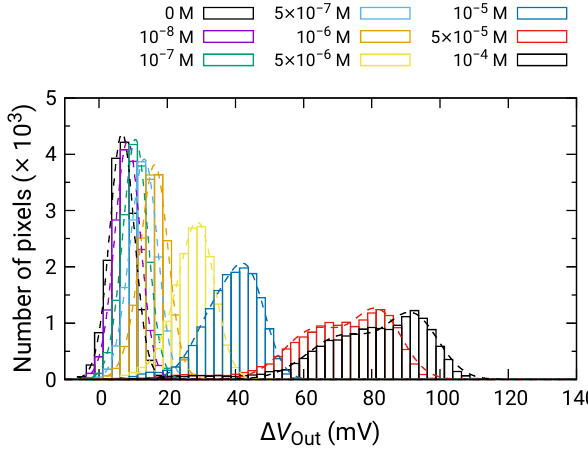
Figure 10. Histogram of ∆ V Out in response to Glu addition.